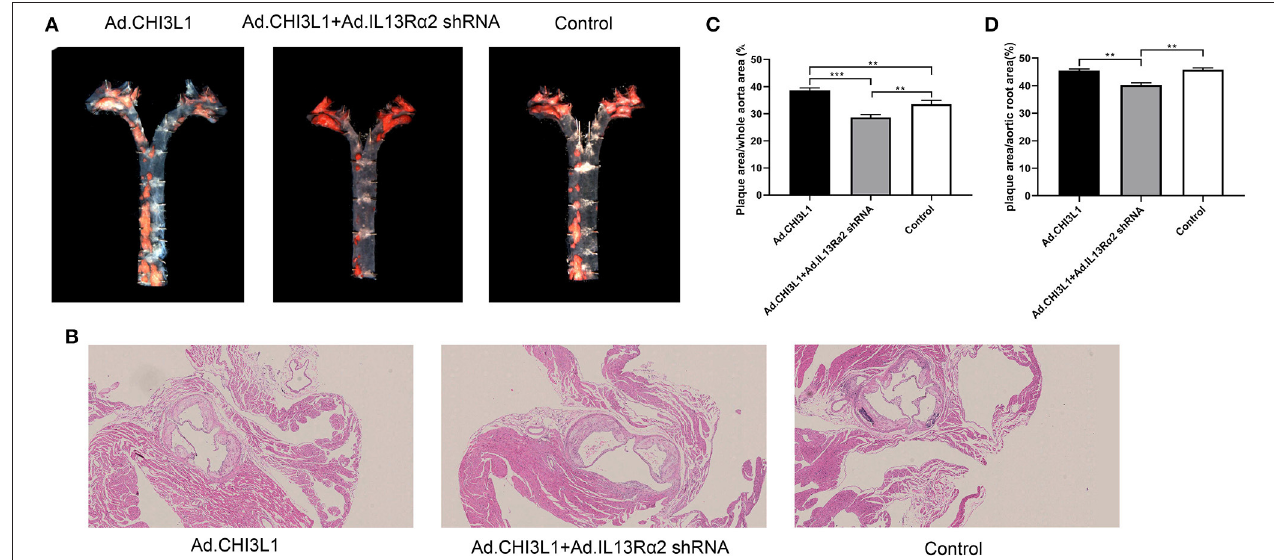
FIGURE 1 | The effect of Chitinase 3-like 1 (CHI3L1) and Interleukin-13 Receptor α 2 (IL-13R α 2) shRNA on the atherosclerotic load of aortas from apoE − / − mice fed with a high-fat diet. General Oil red O-stained aortas and ratio of plaque areas to the whole aorta among three groups (A,C) . H&E stained sections of the aortic root and quantification of cross-sectional areas of plaque in the aortic roots (B,D) . Data were presented as mean ± SD ( n = 3 per group). ** p < 0.01 and *** p <